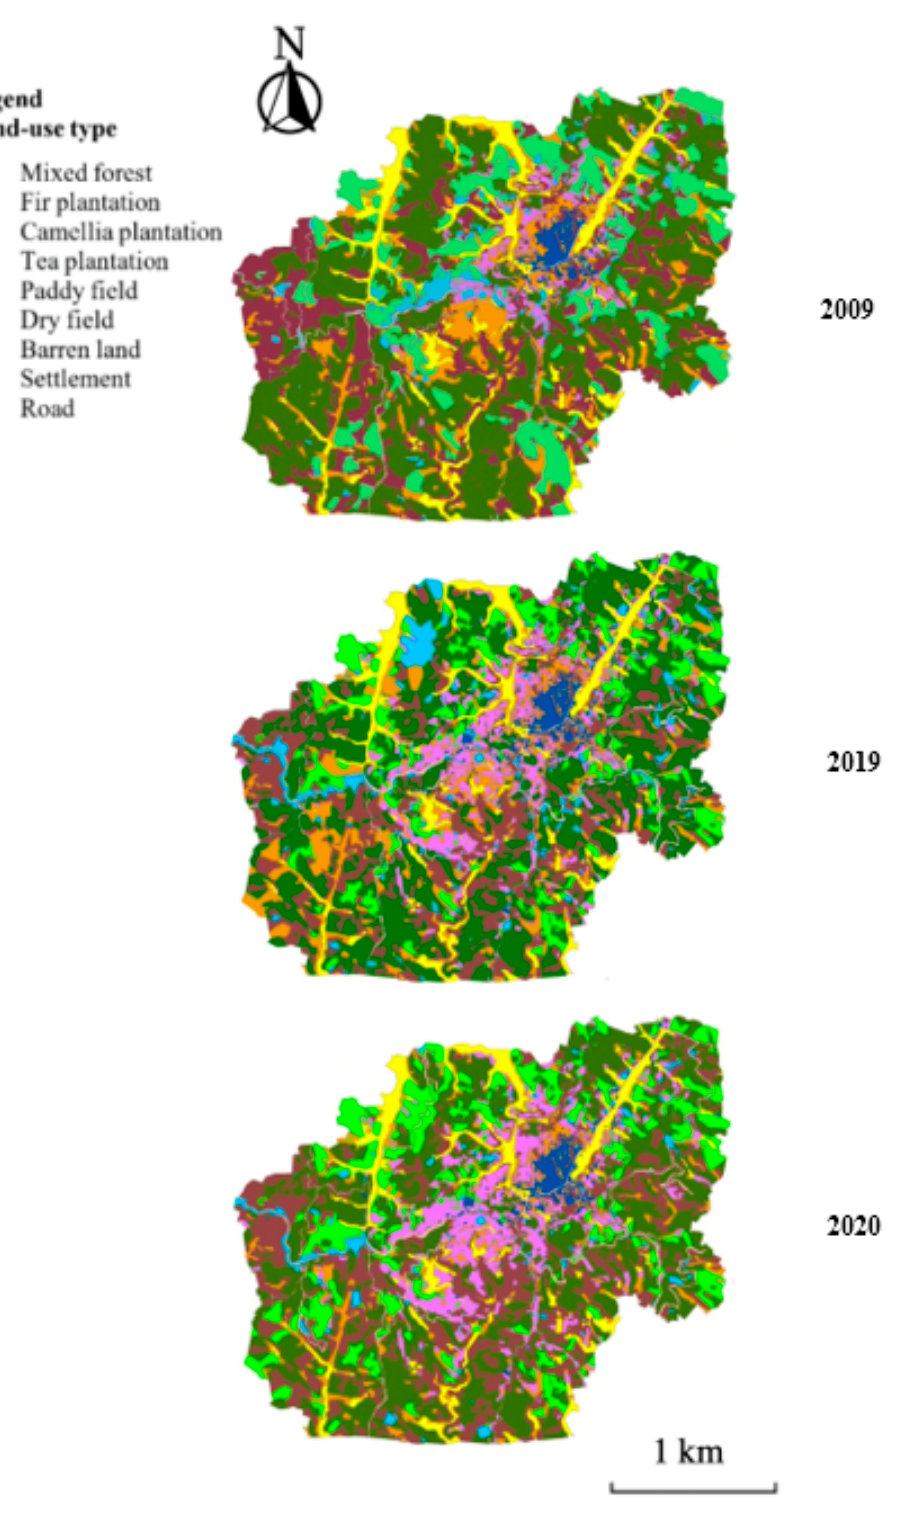
Figure 4. Land use maps for 2009, 2019 and 2020.